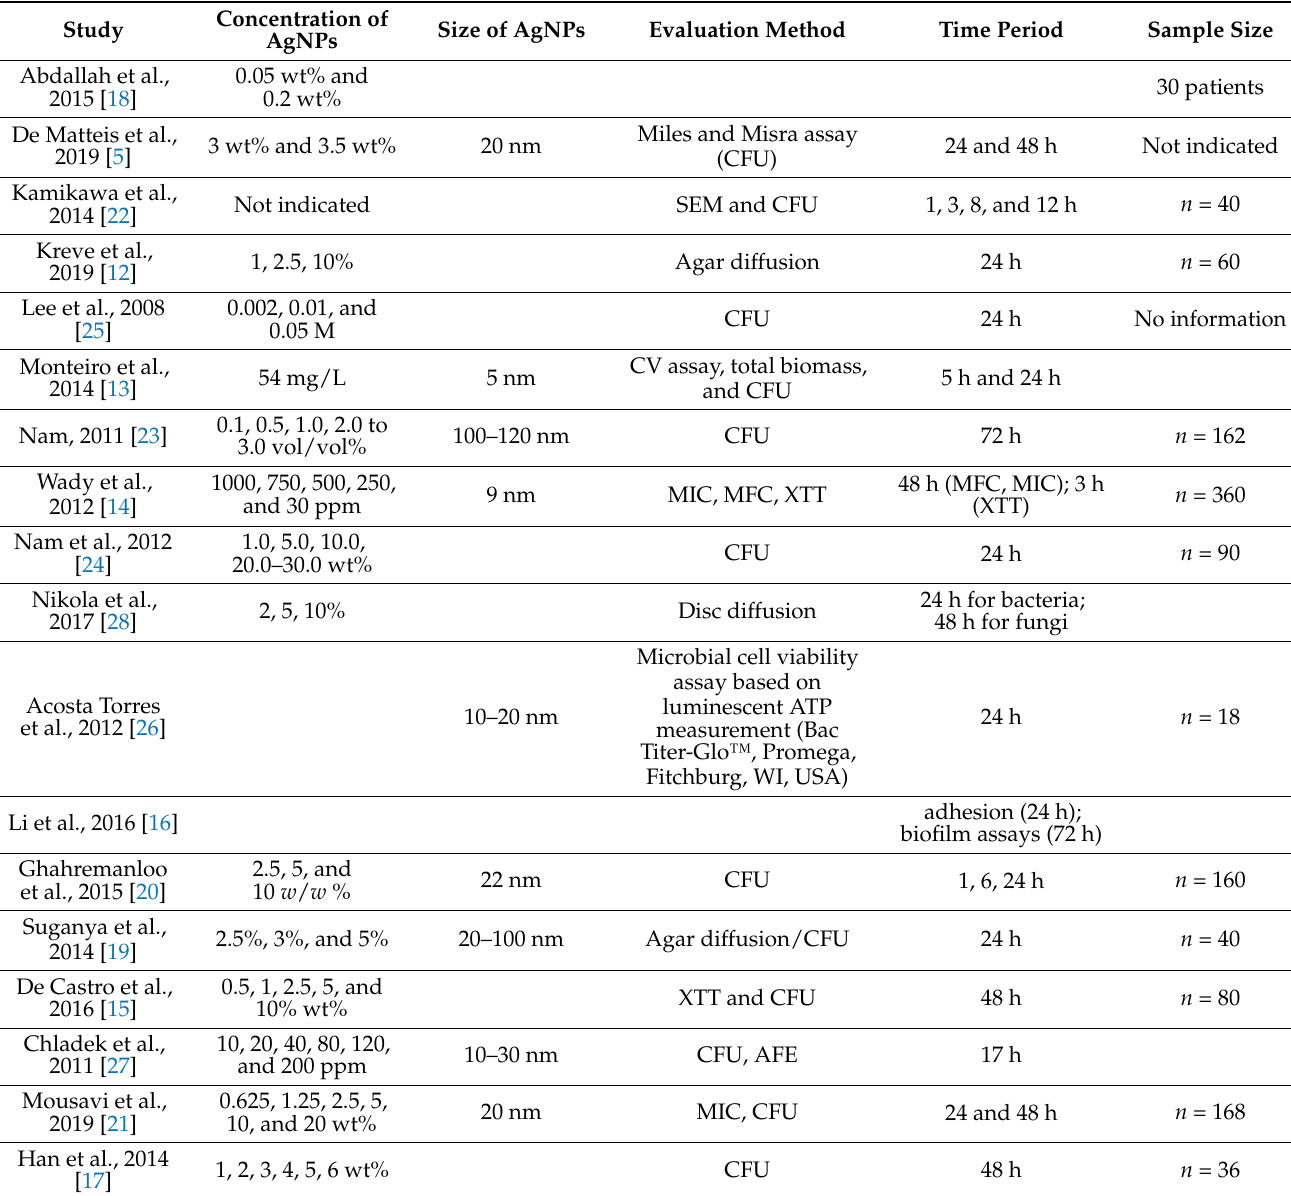
Table 2. Silver nanoparticle details as used in the included